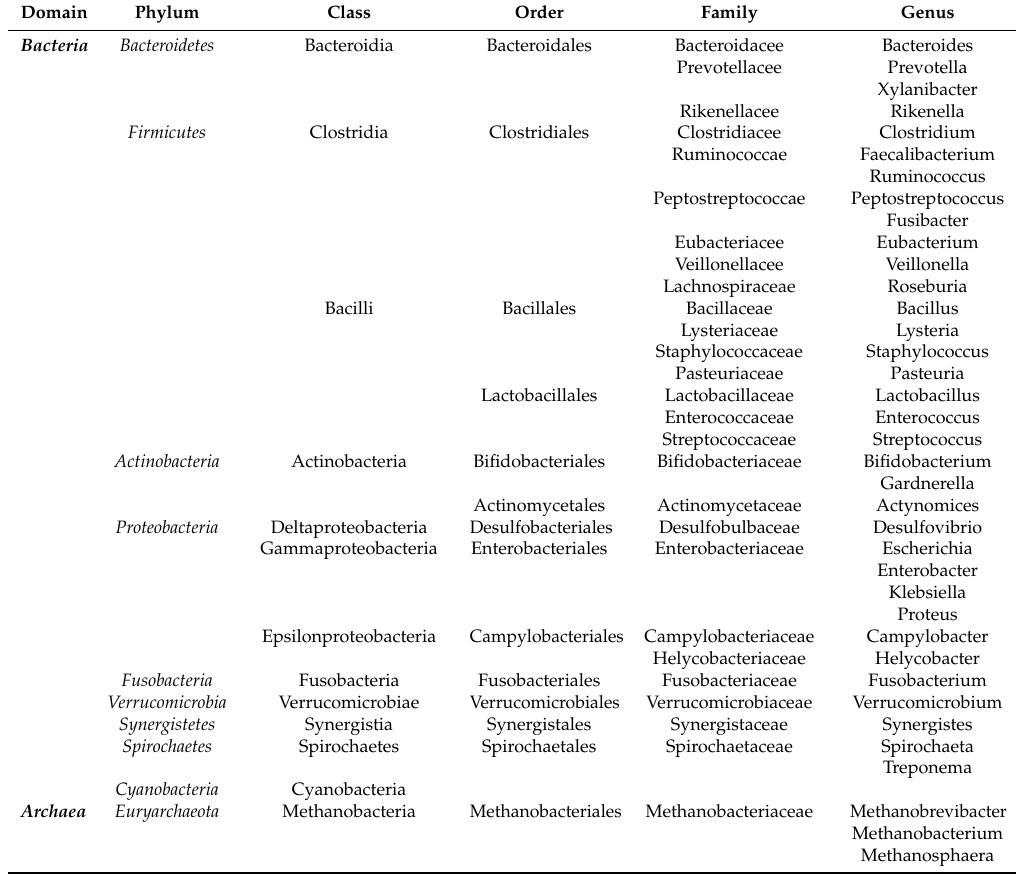
Table 1. Main bacteria and Archaea in the human gut